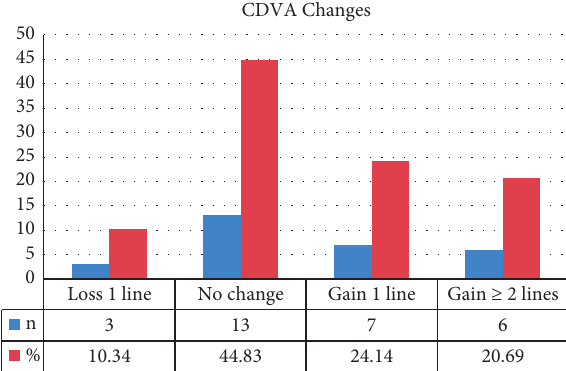
Figure 1: Change in Snellen corrected distance visual acuity (CDVA) following accelerated corneal cross-linking in pediatric patients with keratoconus. Table 2: Topographic and pachymetric outcomes after accelerated cross-linking in pediatric keratoconus.